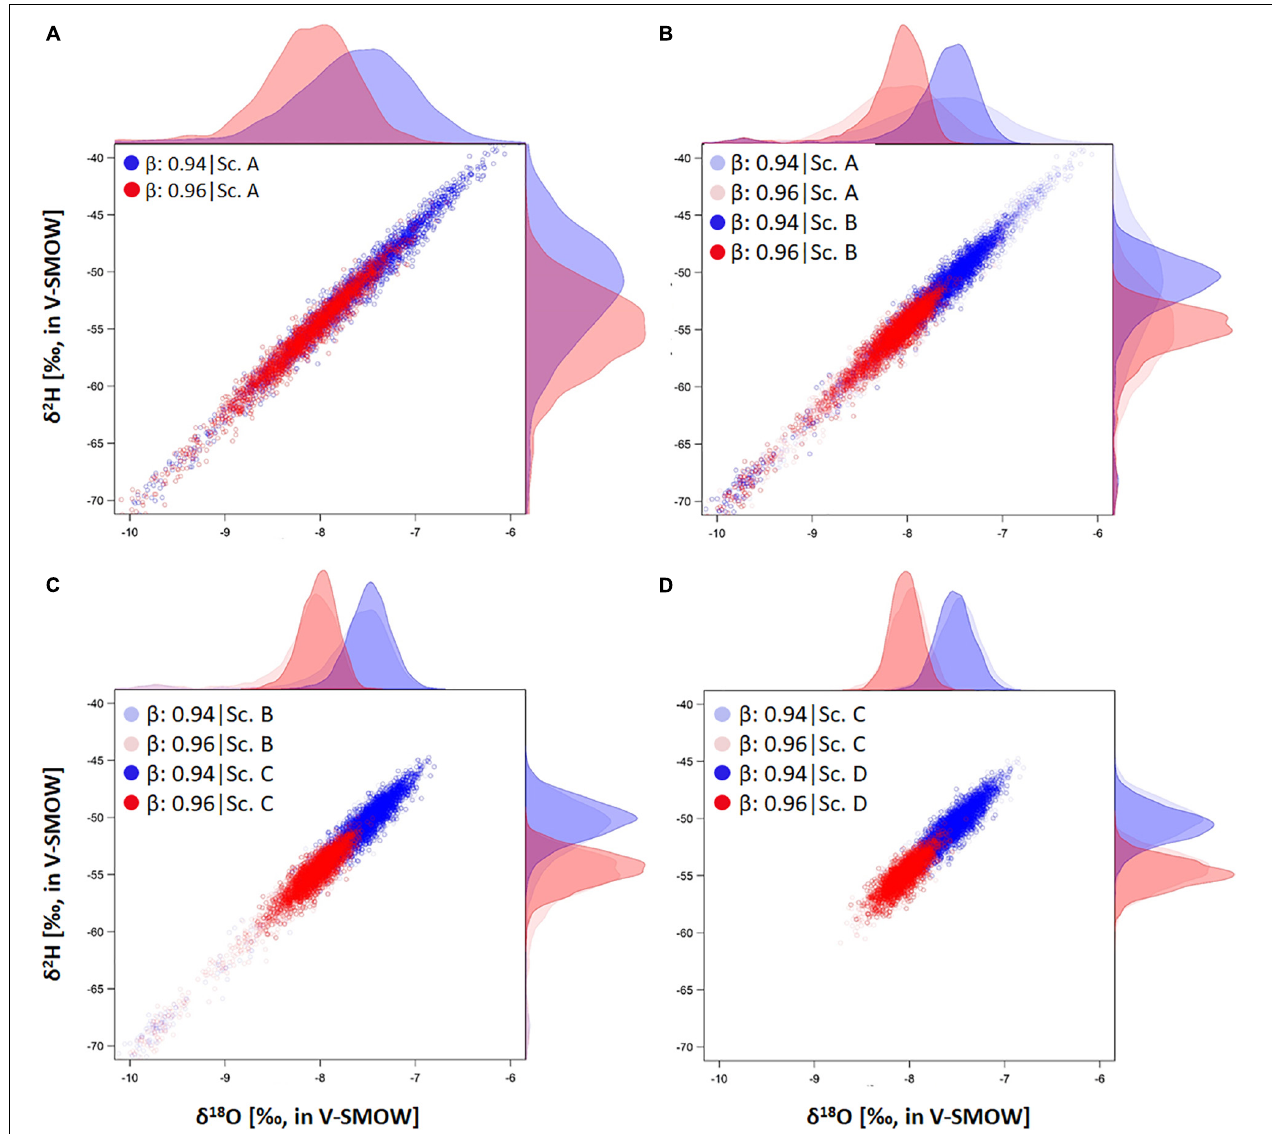
FIGURE 4 | Representation of the simulated conditional probability distribution [i.e., P ( δ xyl | β , χ ) ] of xylem water isotope composition ( δ xyl ) with two distinct profiles in absorbing root surface distribution, i.e., β = 0.94 ( • ) and β = 0.96 ( • ). Each point represents an individual δ xyl sample generated by the SWIFT model. Different panels (A–D) show the results for P ( δ xyl | β , χ ) under different theoretical scenarios - Sc. A: No variable range restrictions are considered. Sc. B: Restriction imposed on the physical variables, i.e., the soil heterogeneity. Sc. C: Restriction of both the physical variables and the sampling strategy. Sc. D: Full restriction, thus considering an additional restriction on the biological plant-specific variables. Shaded colored probability distributions in panel (B–D) enable comparison with the P ( δ xyl | β , χ ) results of the preceding scenario output. P ( δ xyl | β , χ ) per isotope composition, i.e., δ 2 H and δ 18 O, are displayed on the panel sides in the respective color of their β